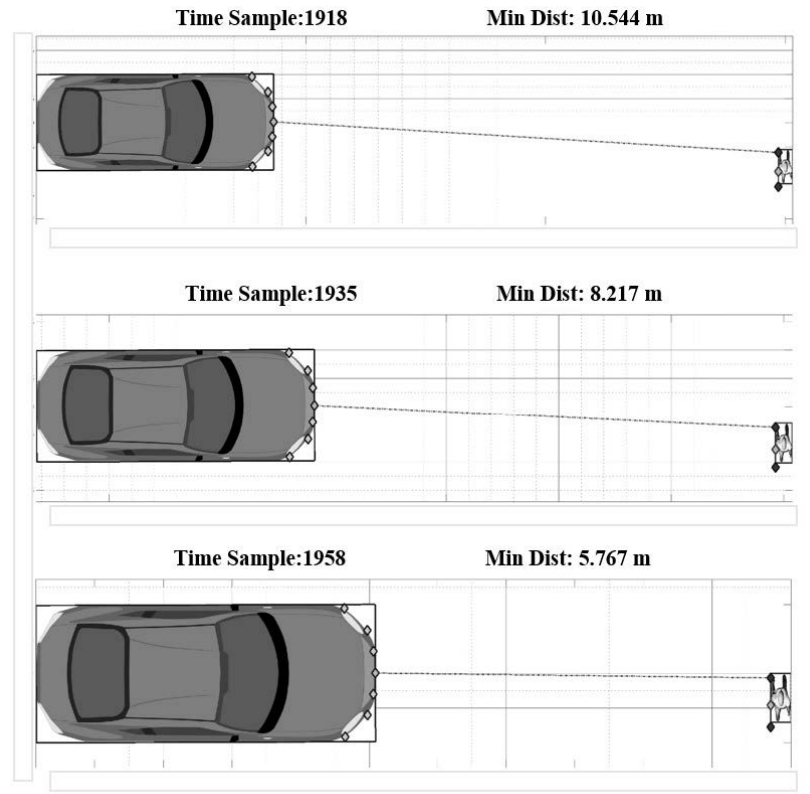
Figure 26. UNECE R152 CPNC 55 km/h replay pictures.